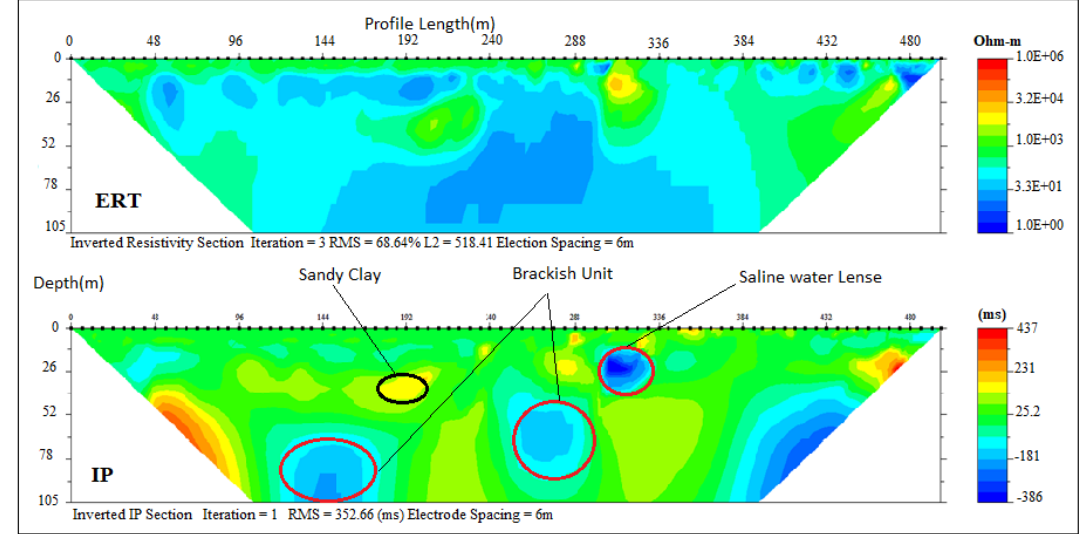
Figure 6. Inverted resistivity and IP cross-sections of Igbokoda (Profile section P3).